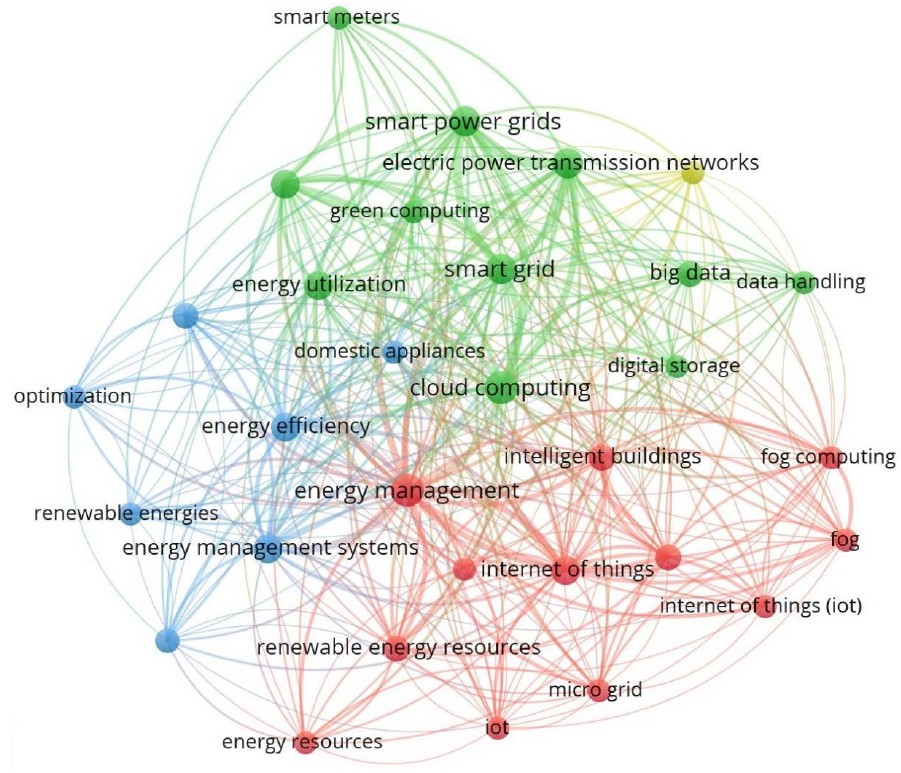
Figure 3. Bibliometric analysis.